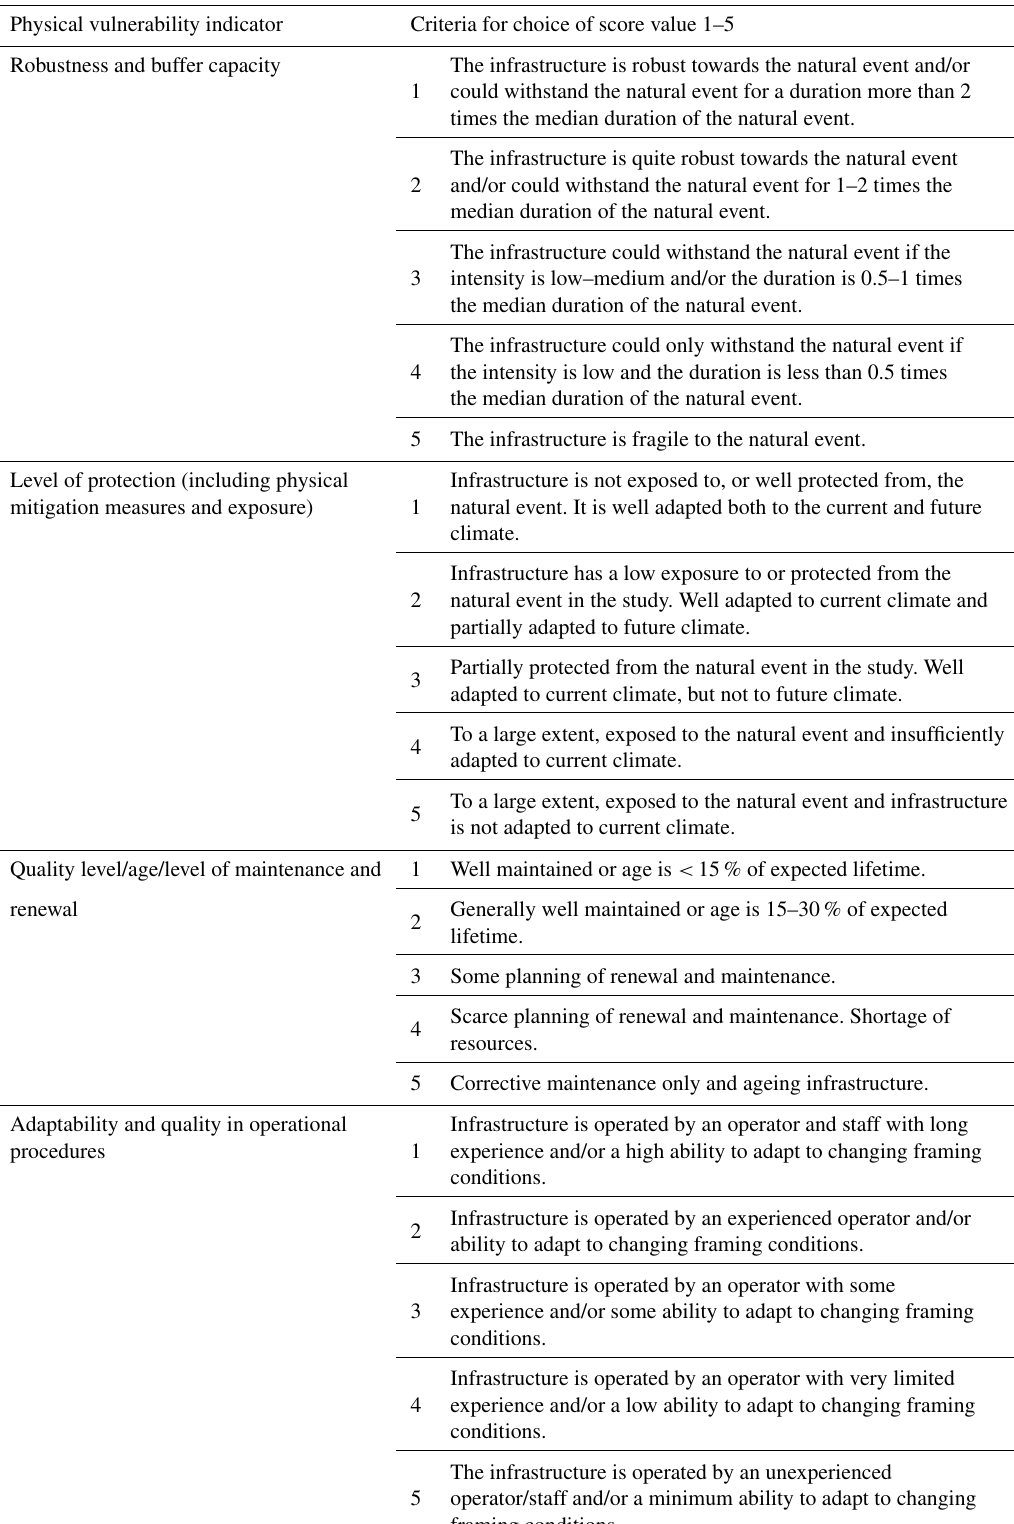
Table 4. Criteria for ranking of the physical vulnerability indicators and barriers affecting the probability of infrastructure loss. For each indicator, the criteria for score values 1–5 are described, where score value 1 corresponds to the lowest vulnerability and 5 to the highest